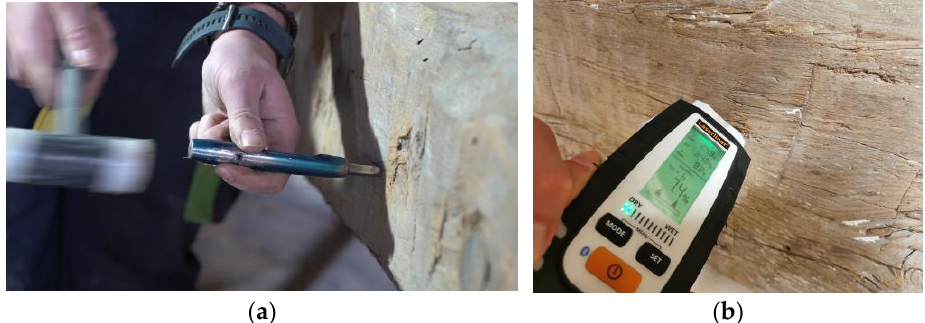
Figure 9. ( a ) Micro-core extraction using the Trephor35 auger. ( b ) Measurement of the moisture content of a beam using a hygrometer.